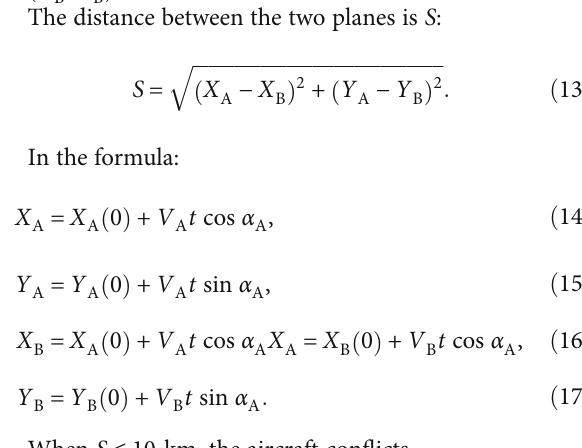
Figure 4: Con fl ict converging point operation